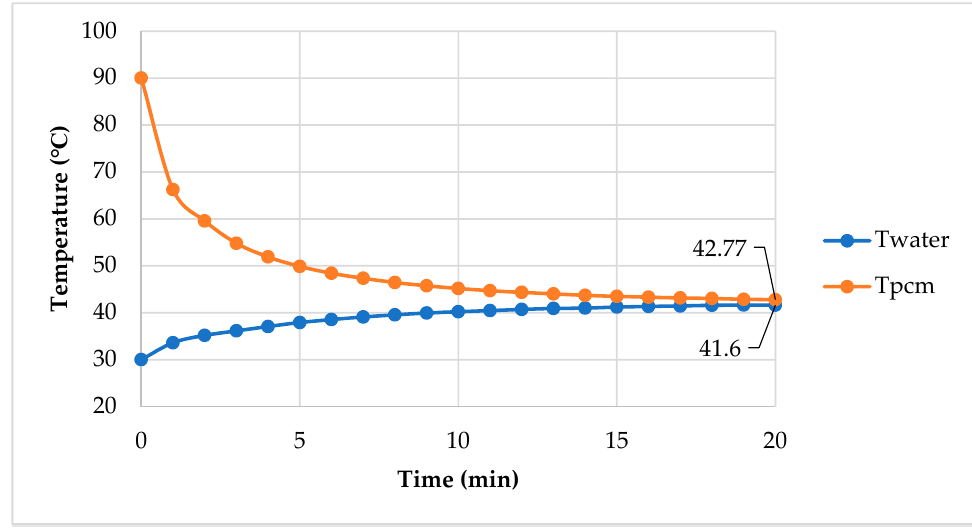
Figure 16. Temperature of hot water and PCMs vs. time.